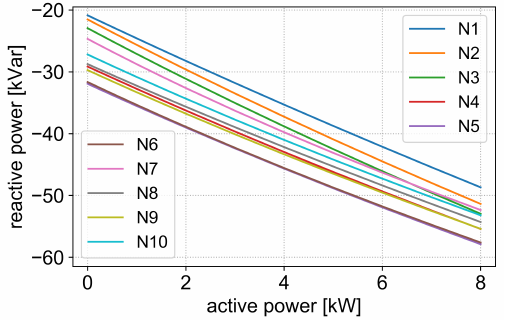
Figure 5. Reactive power demand at nodes N1 to N10 to set local voltage to